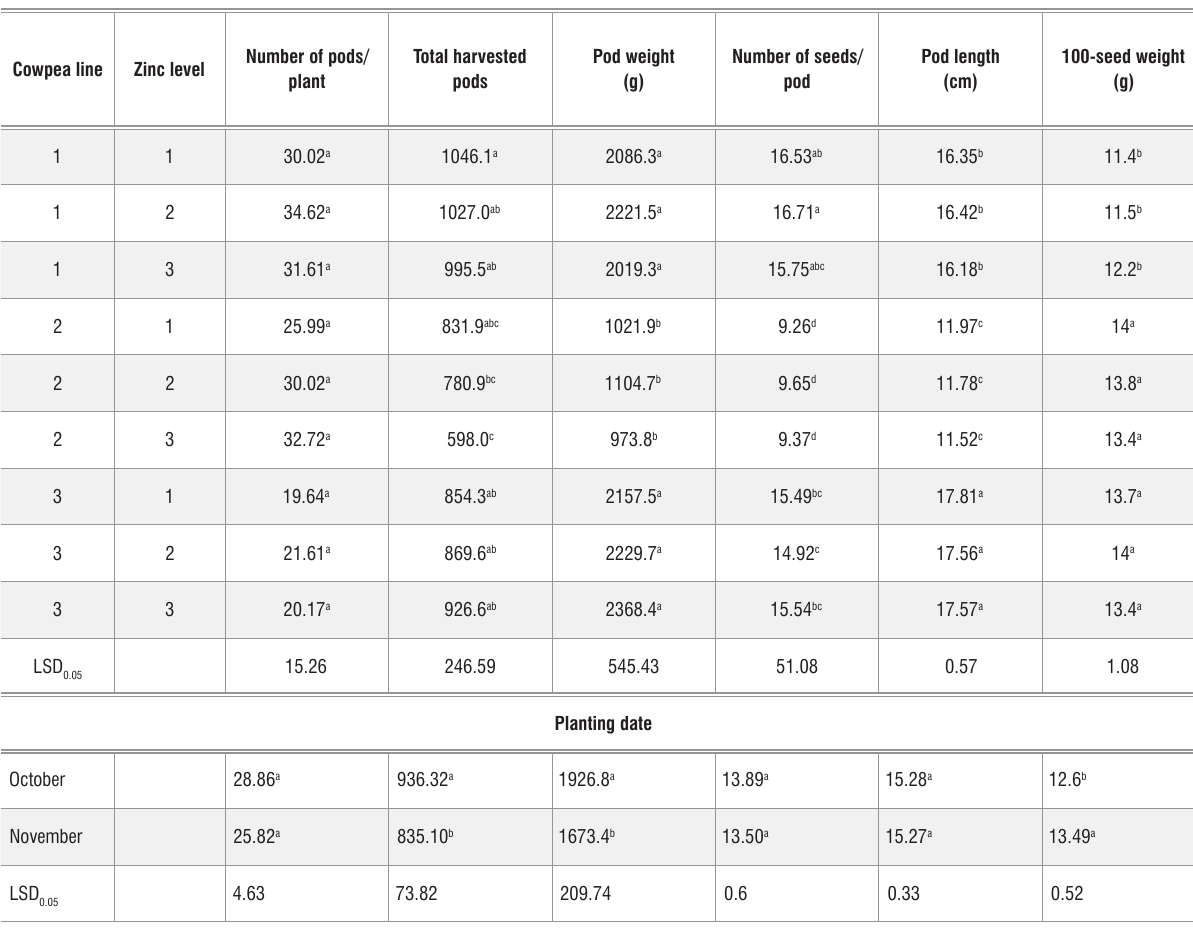
Influence of zinc application and cowpea line on reproductive parameters at Bien Donne’